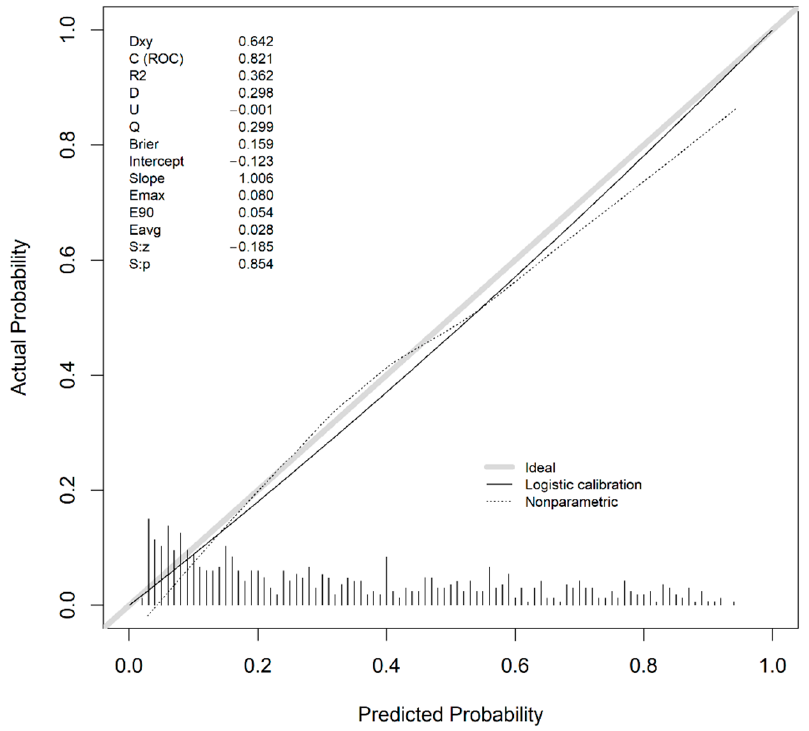
Figure 8. Calibration curve for the external validation dataset.